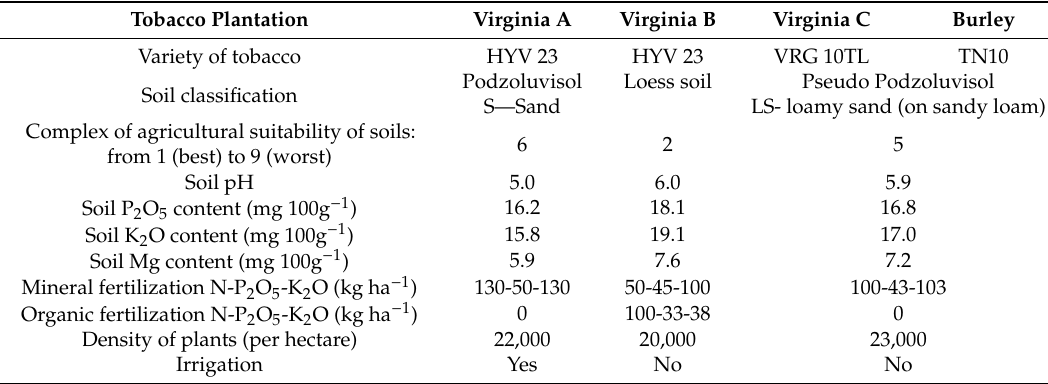
Table 2. Soil properties and fertilization of tested tobacco